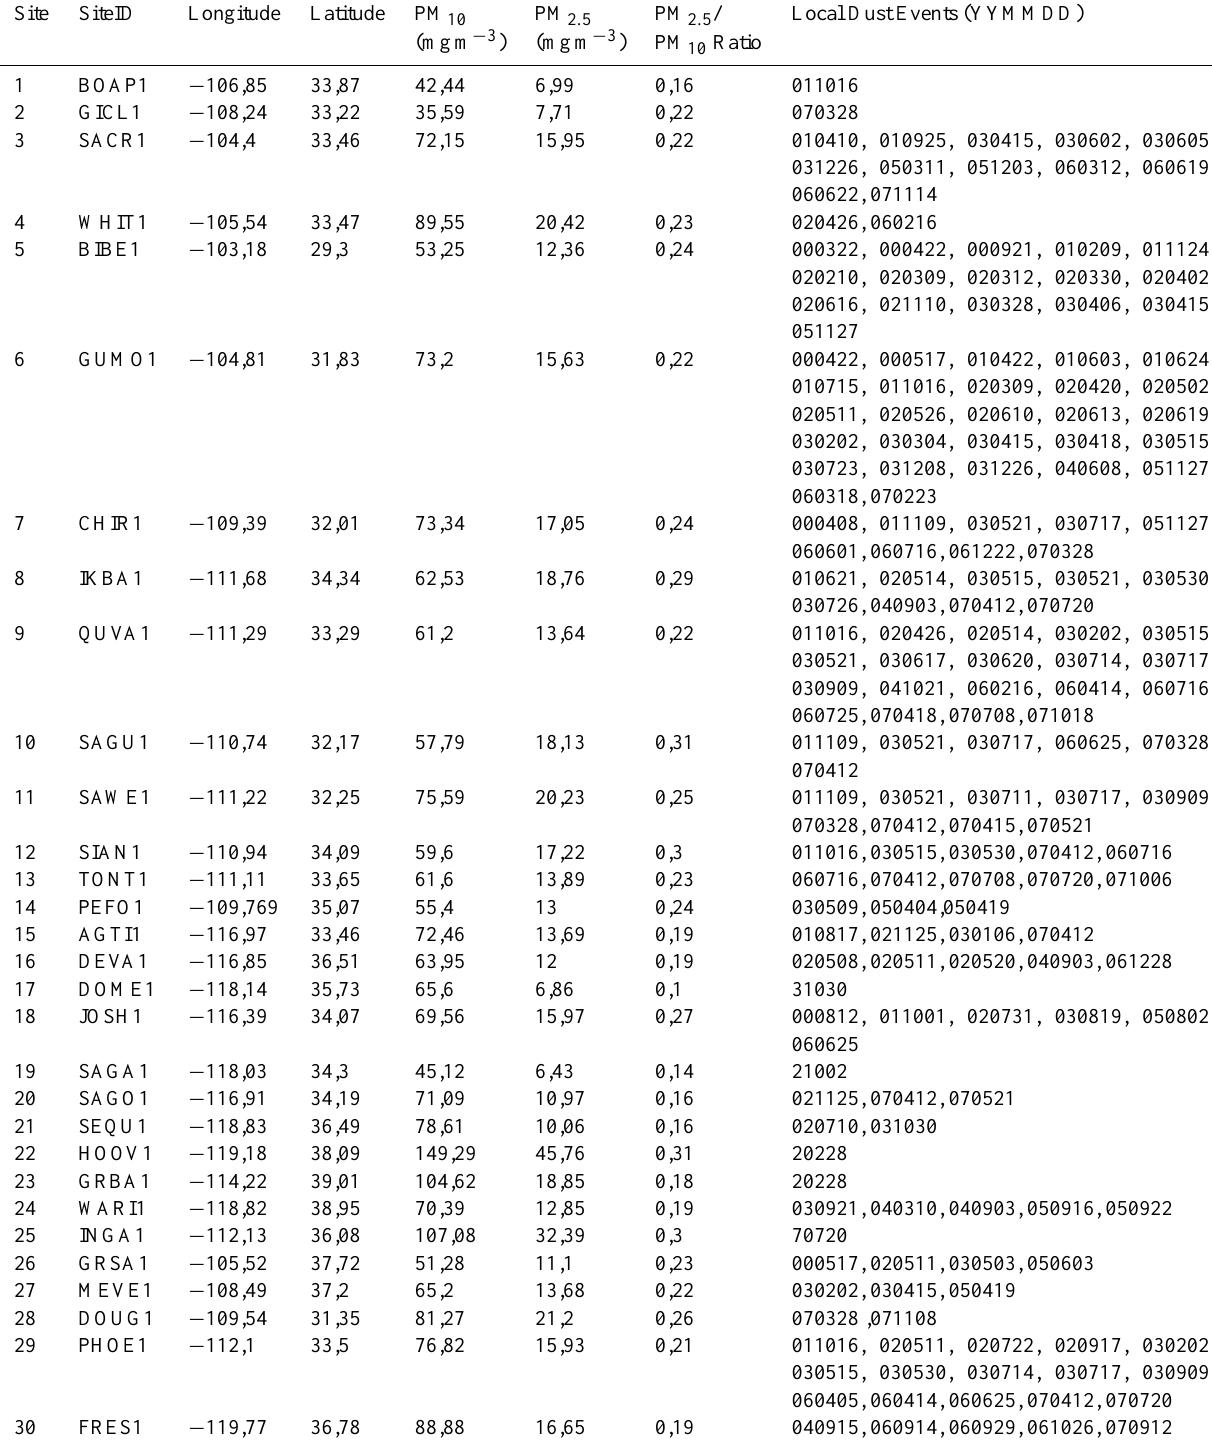
Table 1. Identified local dust events from the IMPROVE monitoring network from 2000 to 2007. The concentrations and ratios listed in the table represent the mean values if there is more than one identified dust